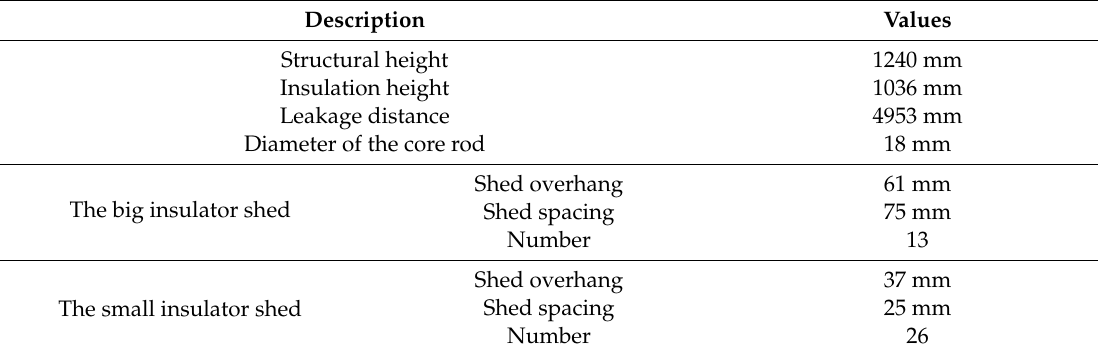
Table 1. Parameters of a composite insulator FXBW-110 /